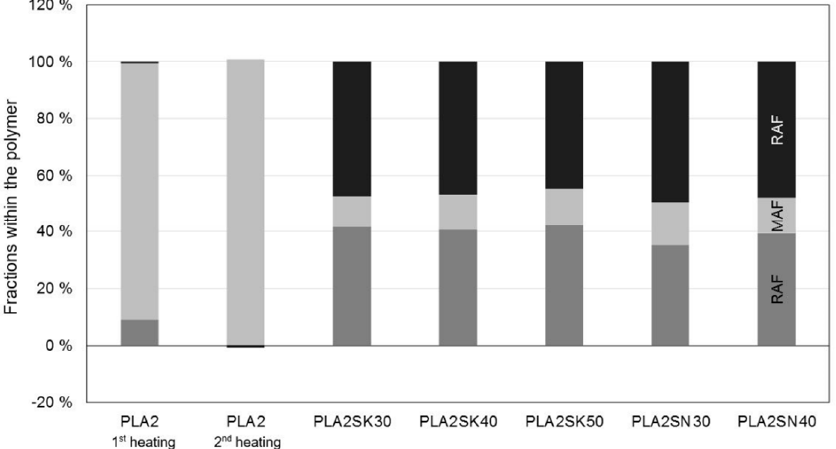
Figure 10. Different properties within the PLA. SK is used for the larger particles, whereas SN describes the smaller particles (in %).